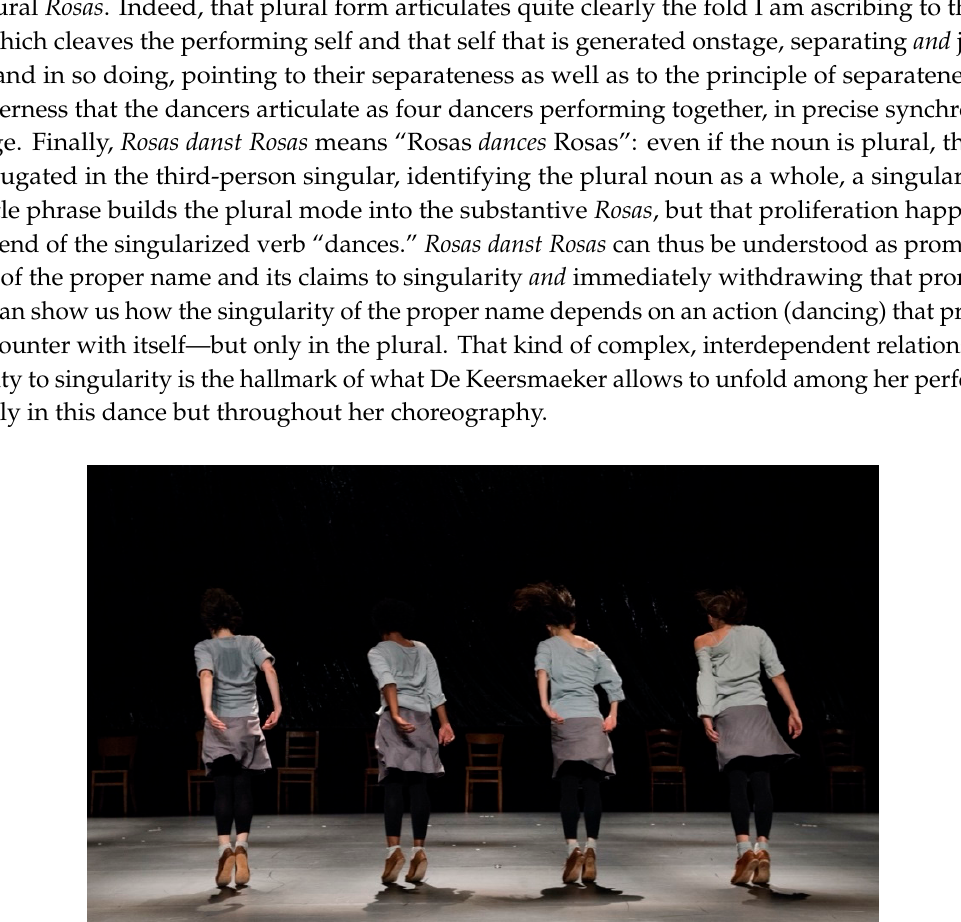
Figure 3. Rosas danst Rosas (2017) Anne Teresa De Keersmaeker/Rosas @ Anne van Aerschot. Used with permission.